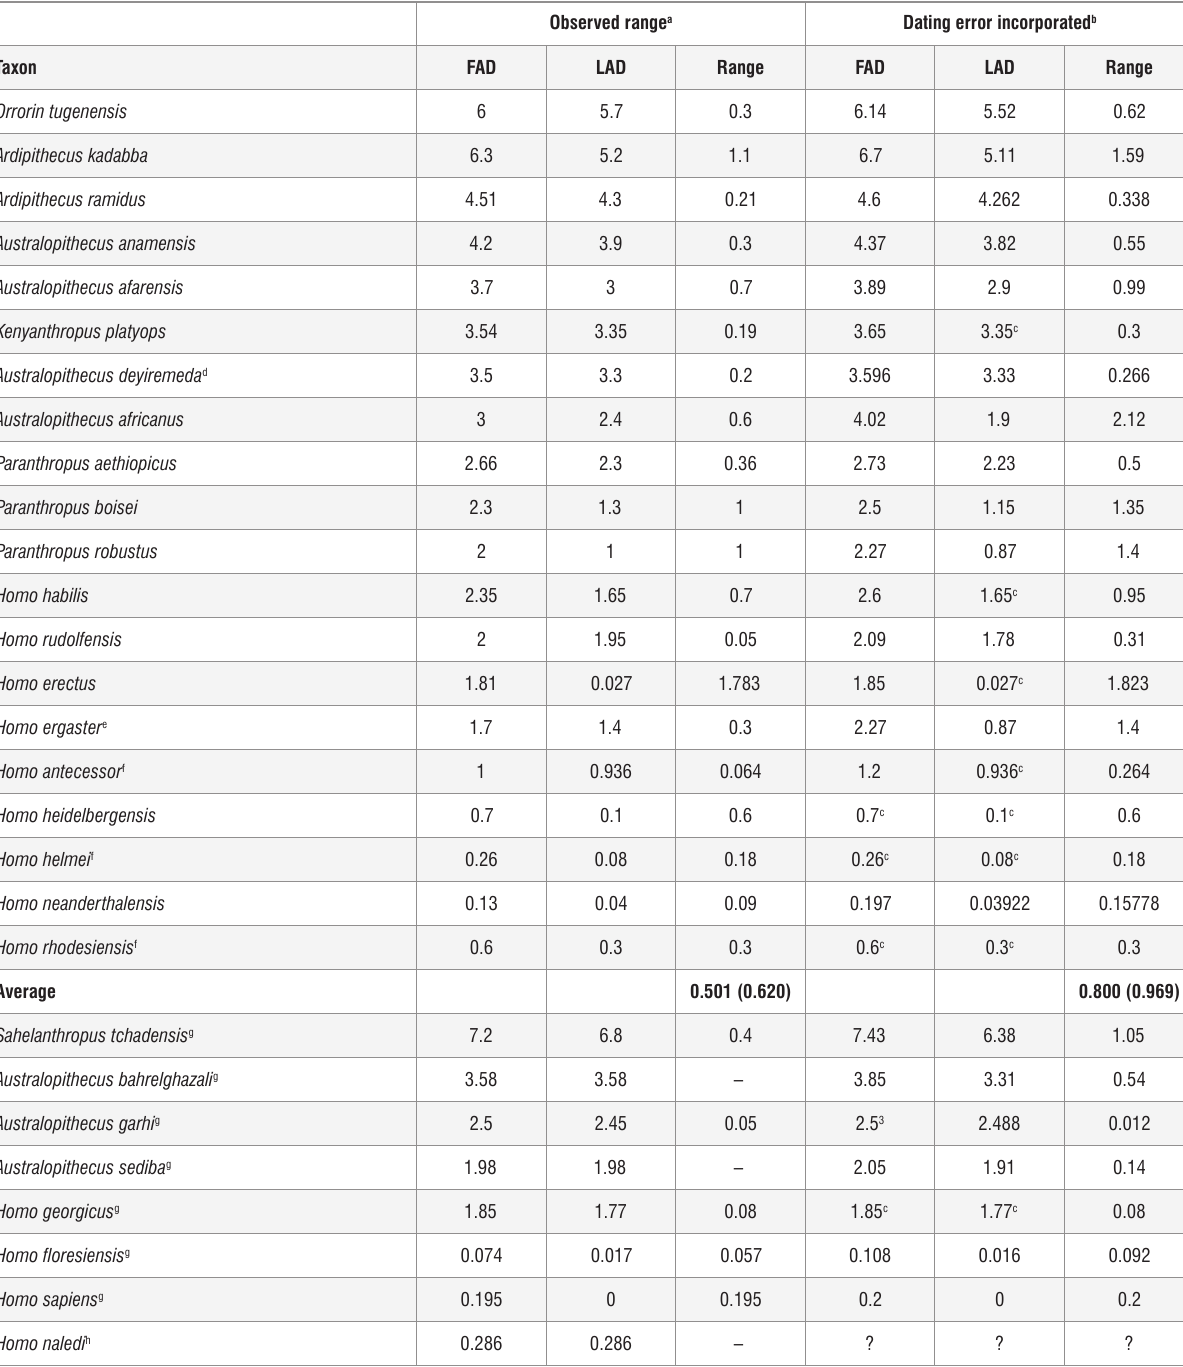
Table 1: Data from Wood and Boyle 56 used to calculate average hominin species duration estimates. The first series represent the ‘conservative’ data with corresponding first appearance date (FAD), last appearance date (LAD) and temporal ranges, while the second series represents the ‘with error’ data. Calculated average hominin durations are provided in bold, with those in brackets generated using a lumping approach. Taxa that were grouped together are indicated by footnotes. Taxa below the dashed line are considered single hits and were not used in average hominin species duration